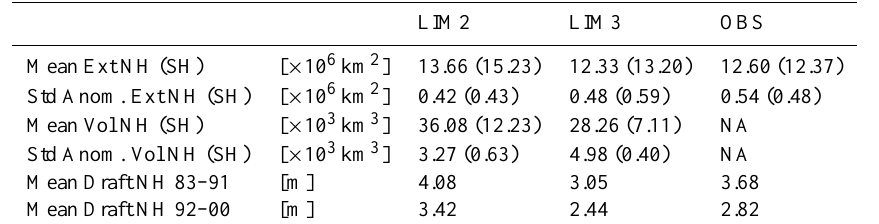
Table 3. Summary statistics for the two simulations, and comparison with observations (NA=Not Available) of: mean annual sea ice extent, standard deviation of the monthly anomalies of ice extent, mean annual volume, standard deviation of the monthly anomalies of ice volume, mean ice draft in central Arctic (latitude > 80 ◦ N) between 1983 and 1991, and between 1992 and 2000. Parentheses correspond to the Southern Hemisphere.